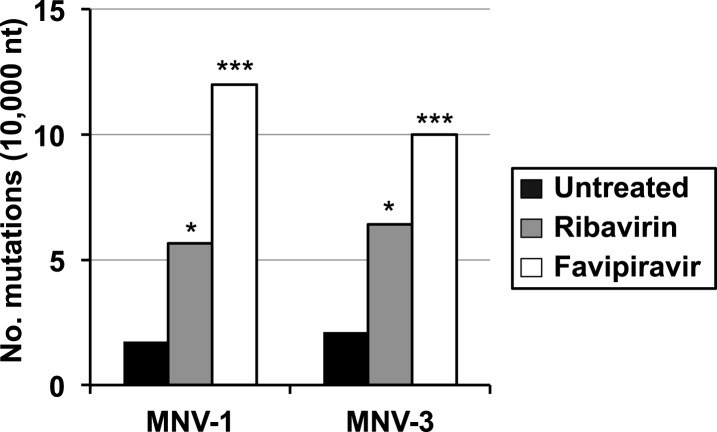
Increased mutation frequencies in virus quasispecies treated with ribavirin or favipiravir.Mutation frequencies are represented as the average number of mutations found every 10,000 nucleotides sequenced in MNV-1 and MNV-3 populations after 4 passages in RAW264.7 cells in the absence or presence of 200 μM ribavirin (RBV) or favipiravir (FPV) (p < 0.05, *; p < 0.001, ***, Mann–Whitney U test).